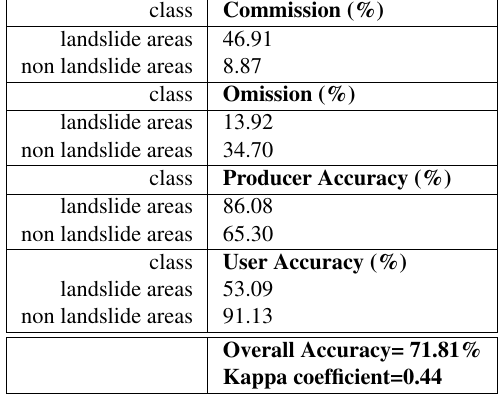
Table 2: Confusion Matrix of SVM classification using the seven